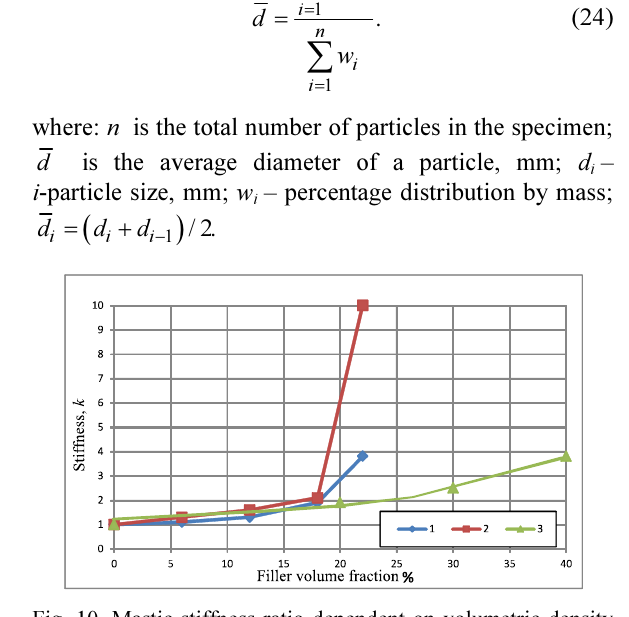
Fig. 10. Mastic stiffness ratio dependent on volumetric density of fillers were: 1 – particle size is 5 µm (Chen et al. 2007); 2 –particle size is 75 µm (Chen et al. 2007); 3 – curve by Sha- shidhar and Shenoy (2002) According to Eqn (27), the average particle size D = 7.1 mm in AC 16 PD 70/100 asphalt concrete. Theo- retical matrix